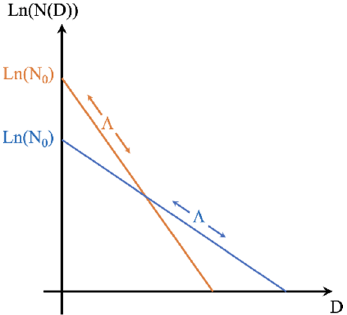
Figure 1. A schematic illustrating how the choice of the intercept parameter N 0 affects the characteristics of the Particle Size Distribution, in the case of an assumption for an exponential form of the distribution. The two lines represent two distributions that integrate to the same amount (mass q-the integral under the curve), while having very different intercept N 0 and slope Λ. The Particle Size Distribution (PSD) distribution represented by the blue line has a smaller number of small particles and a larger number of large particles as compared to the distribution represented by the orange curve.